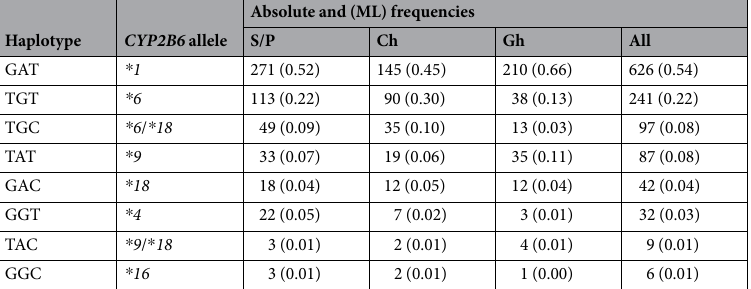
Table 3. Haplotype frequencies by district and for all the samples combined. Maximum-likelihood (ML) haplotype frequencies were calculated using the EM algorithm in